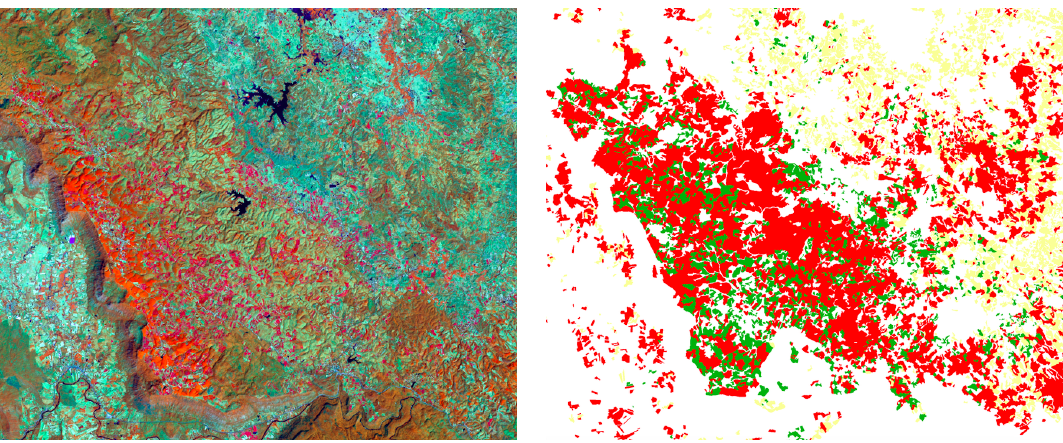
Figure 6. The example of satellite images from the Landsat-8w3c corpus, northern province (left) and target image (right). The ground-truth of the medium resolution data set includes three classes: para rubber (red), pineapple (green), and corn (Yellow).